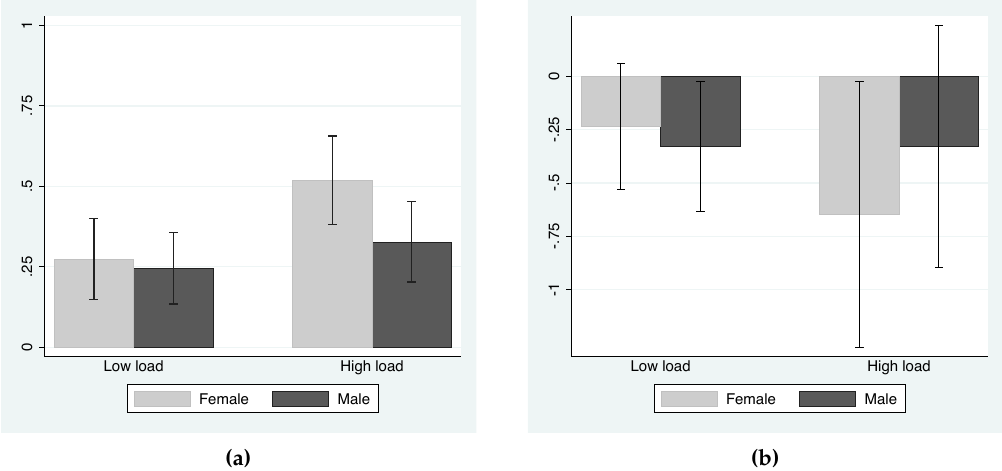
Figure 2. Revised donations by cognitive load and gender with 95% confidence intervals. ( a ) Revision rate; ( b ) Mean revision size in